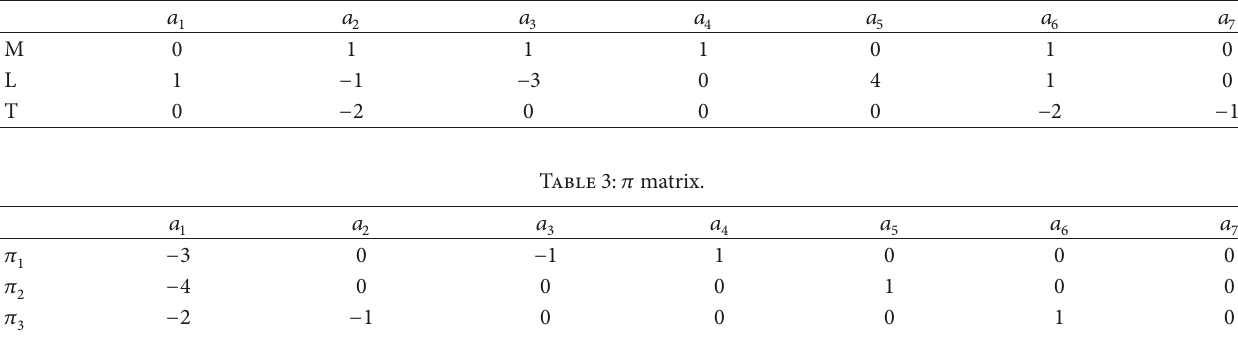
Table 2: Dimension matrix of the horizontal drill string dynamics system.